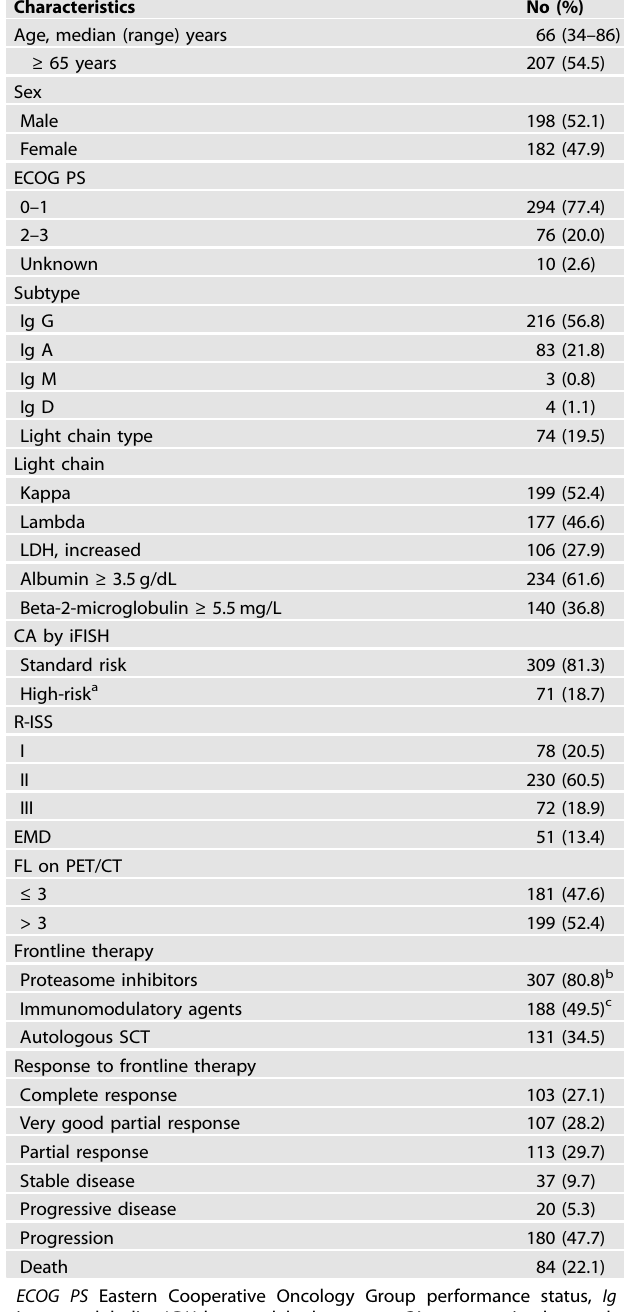
Table 1. Patient characteristics ( n =